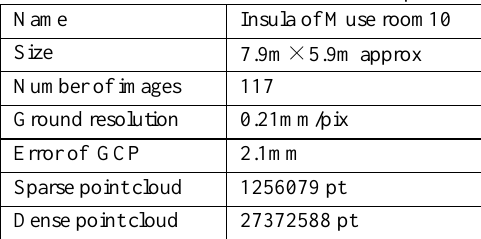
Fig.7 Orthographic image created from point cloud Table 1 Detail information of SFM: sample1